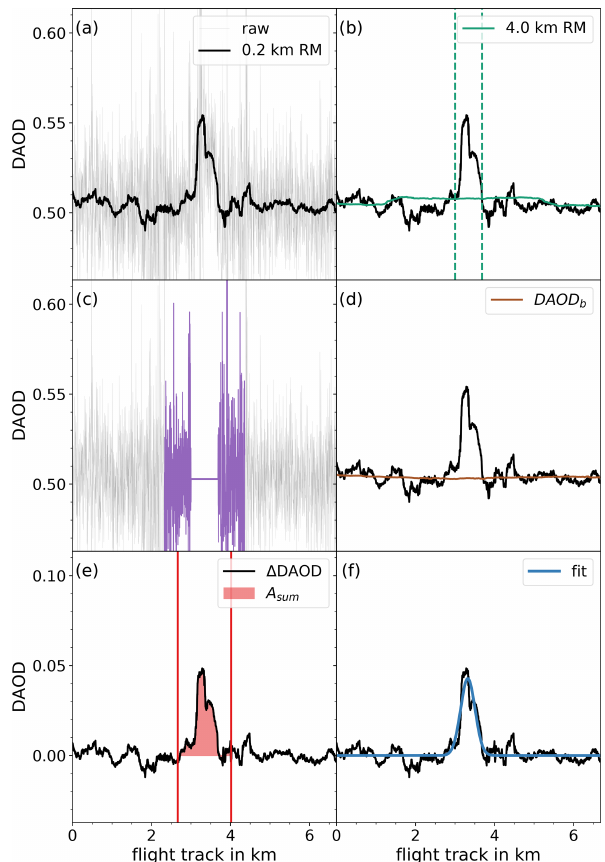
Figure 3. Plume crossing at a point source distance of 1.53km. In (a) the gray curve shows the raw data, with a standard deviation of 5.2%, while the black curve shows a 0.2km (64 data points) running mean (RM), with a standard deviation reduced to 0.9%. In (b) the green curve is a 4km (1293 data points) RM. Vertical dashed green lines mark the intersections between the 0.2 and 4km RMs, which are defined as the plume’s limits. The color purple in (c) shows the region of the data used to construct a mean value of the data before and after the plume’s limits. This mean value is used to bypass the plume enhancement and is also colored purple. In (d) again a 4km running mean over the bypassed dataset is shown in brown. These data, which have slight variability, are used as the background term DAOD b . Finally, in (e) and (f) the enhanced term (cid:49) DAOD, i.e., difference between 0.2km RM and DAOD b , is plot- ted in black. Note the different scale on the y axis. In (e) the area underneath the curve is colored red as an example of the parameter A sum determined with a Riemann sum. Alternatively, a Gaussian fit can be applied to (cid:49) DAOD, providing the parameter A fit as a fit- parameter, shown as a blue line in (f)